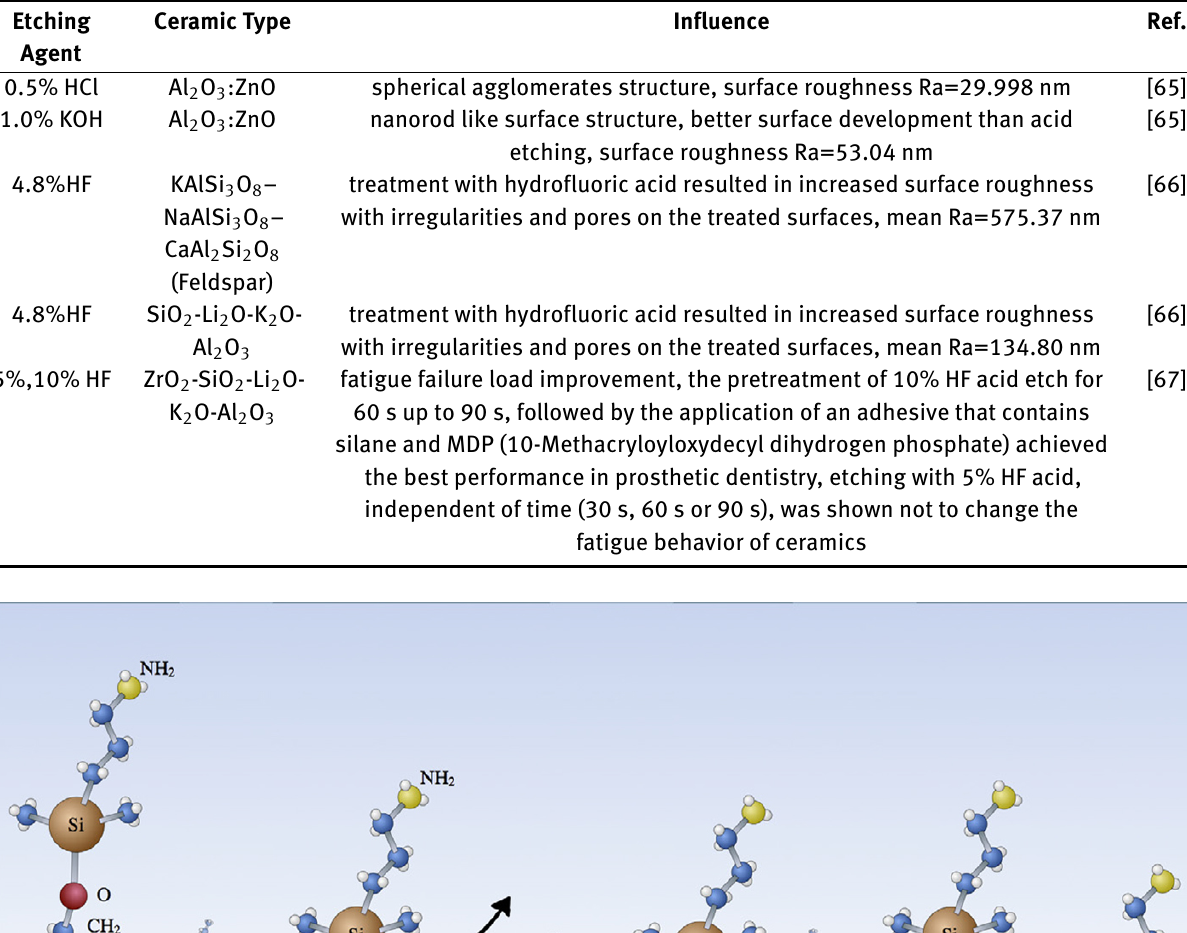
Table 5: Chemical etching characteristics for various dental bioceramics Etching